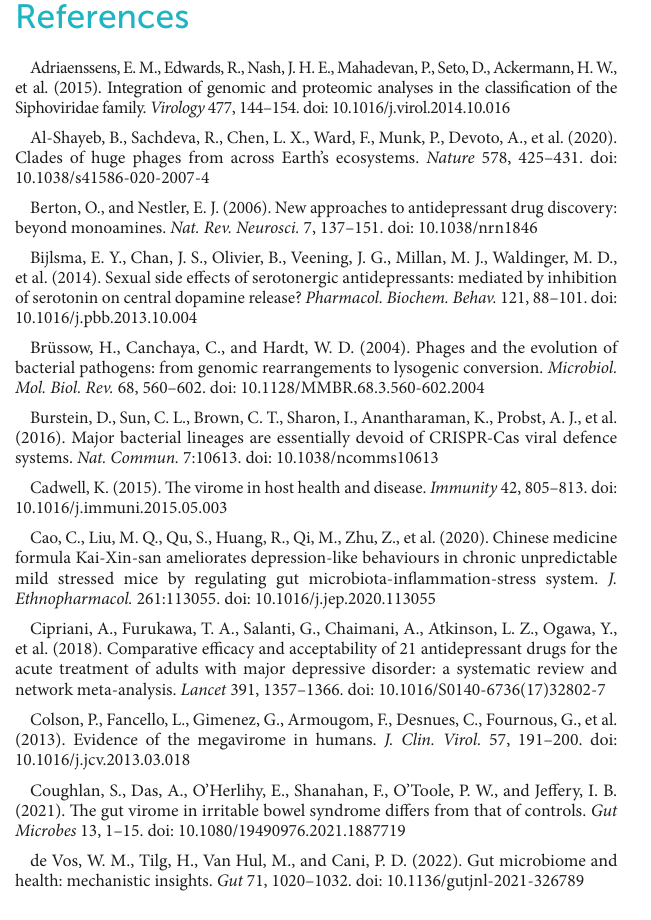
The DNA viral composition and taxa at the genus levels among the five groups. (A) Community pie-chart showing the proportion of viral operational taxonomic units (vOTUs) that were assigned to viral taxa at the genus level. (B) Bar plot showing the gut viral abundance of all samples at the genus level. (C) The Venn diagram showed that the common and unique gut virome among the five